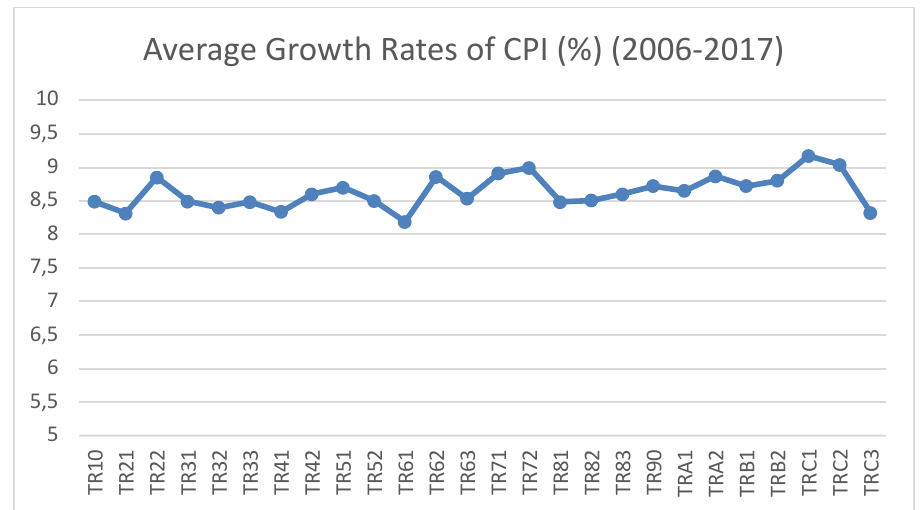
Figure 3: Average Growth Rates of CPI (NUTS2) (%) (2006-2017)